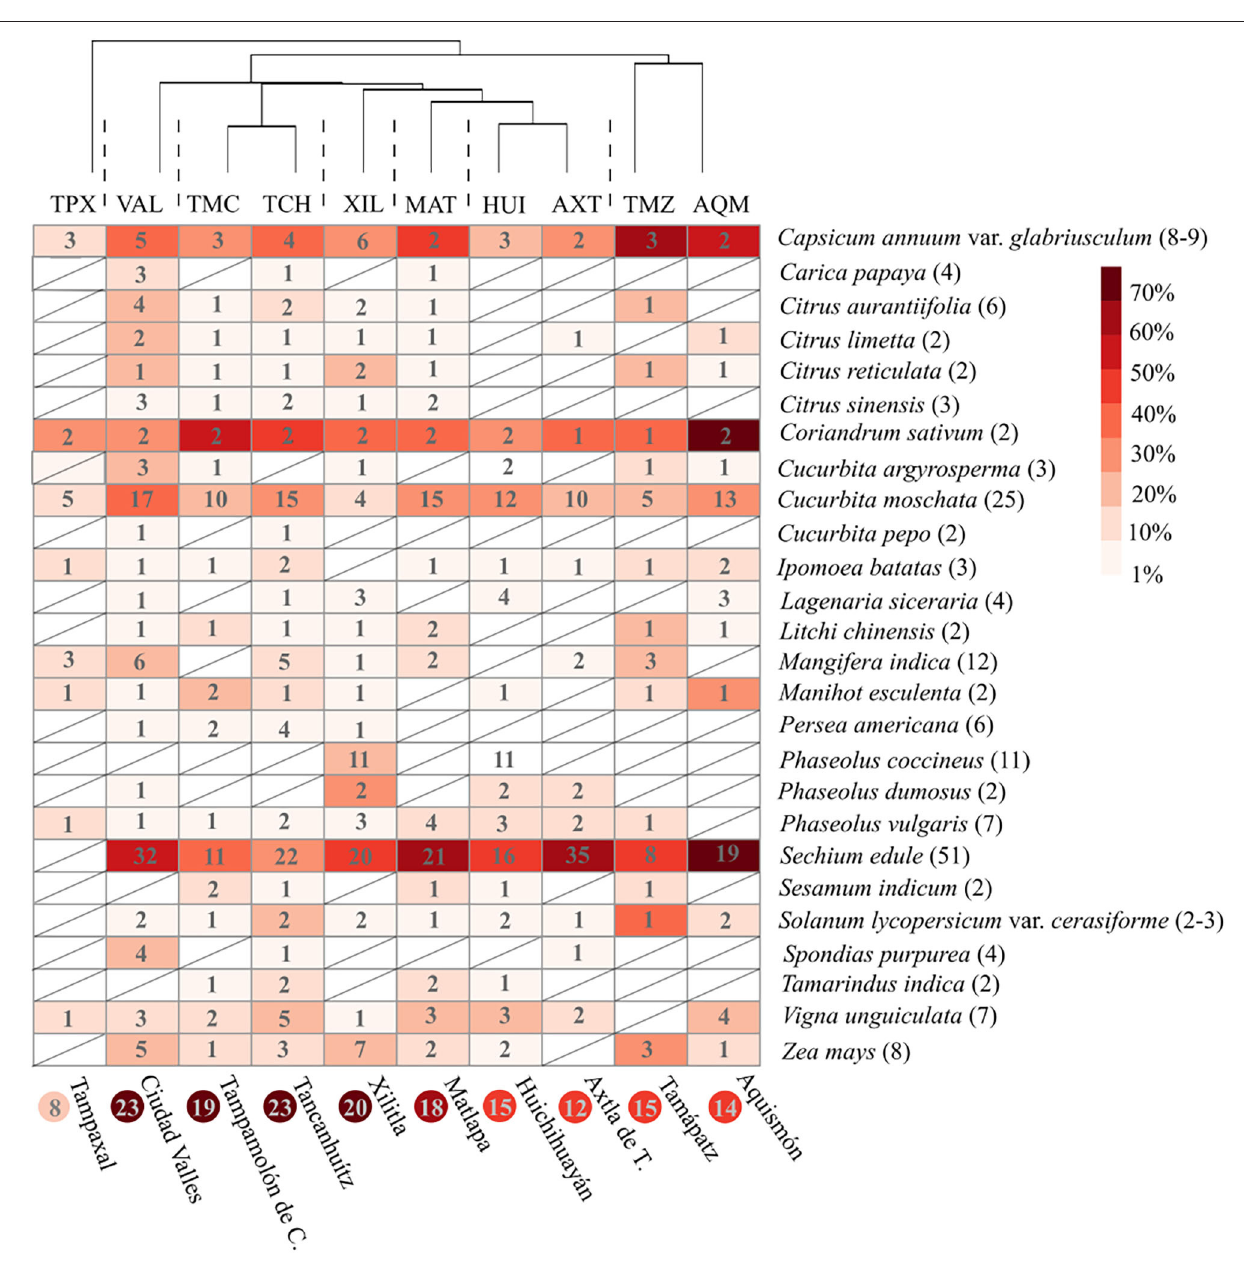
(TMZ) and Aquismón (AQM) share a high proportion of